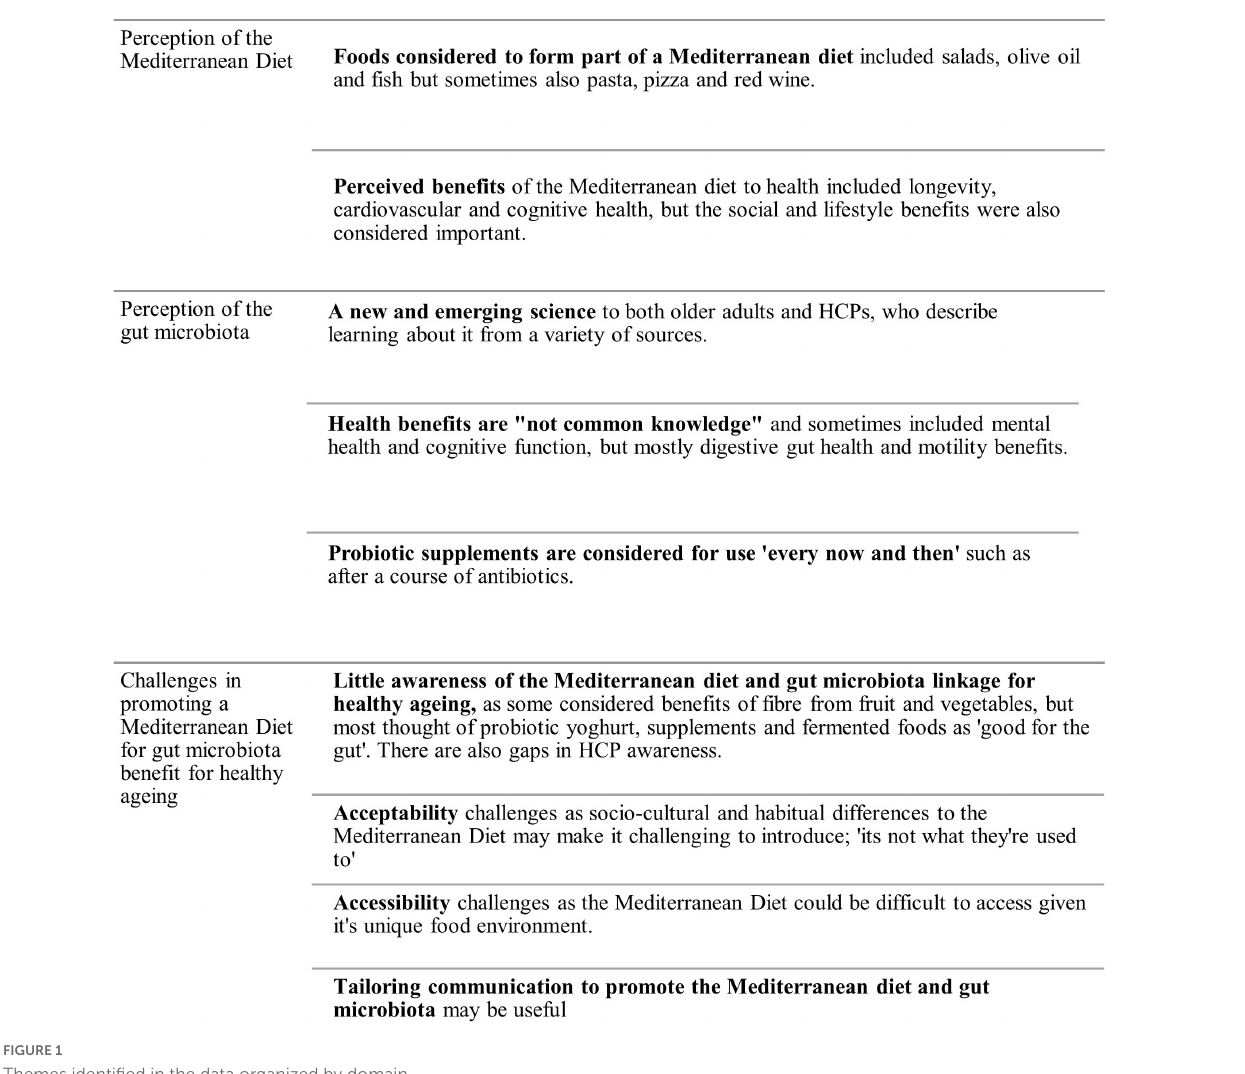
FIGURE1 Themes identified in the data organized by